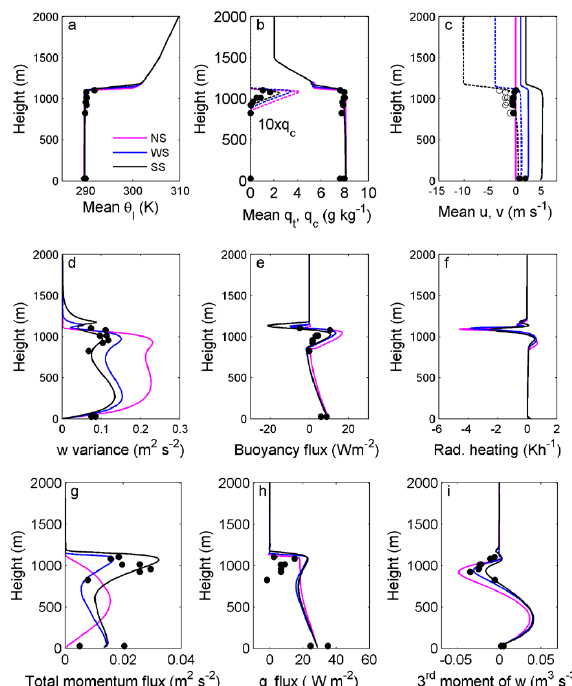
Fig. 3. LES simulated and observationally derived mean and turbulence variables. Solid or dashed lines denote the simulated results; the circles are the leg averaged values de- rived from measurements. (a) ¯ θ l ; (b) ¯ q t or ¯ q c ; (c) ¯ u (solid) and ¯ v (dashed), the solid and open circles are for observed ¯ u and ¯ v , respectively; (d) w 0